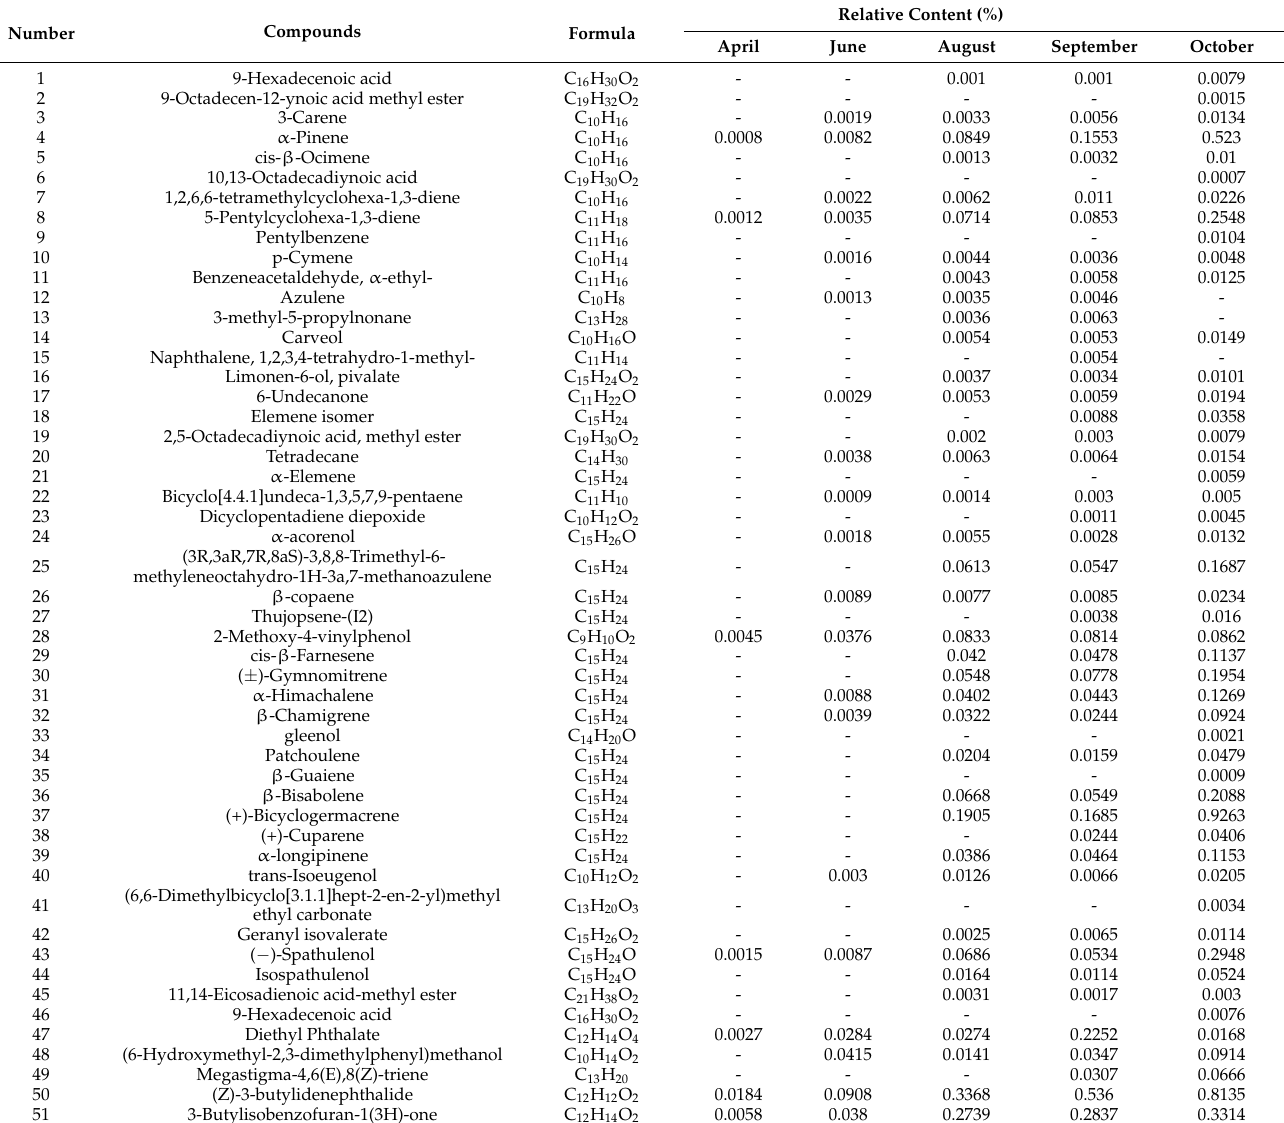
Figure 6. Total ion chromatogram from the tail of A. sinensis in different periods. Note: The com- pounds represented by peaks 1~9 are the same as the compounds in Figure 2. Table 3. Analysis of chemical composition in the tail of A. sinensis in different periods.